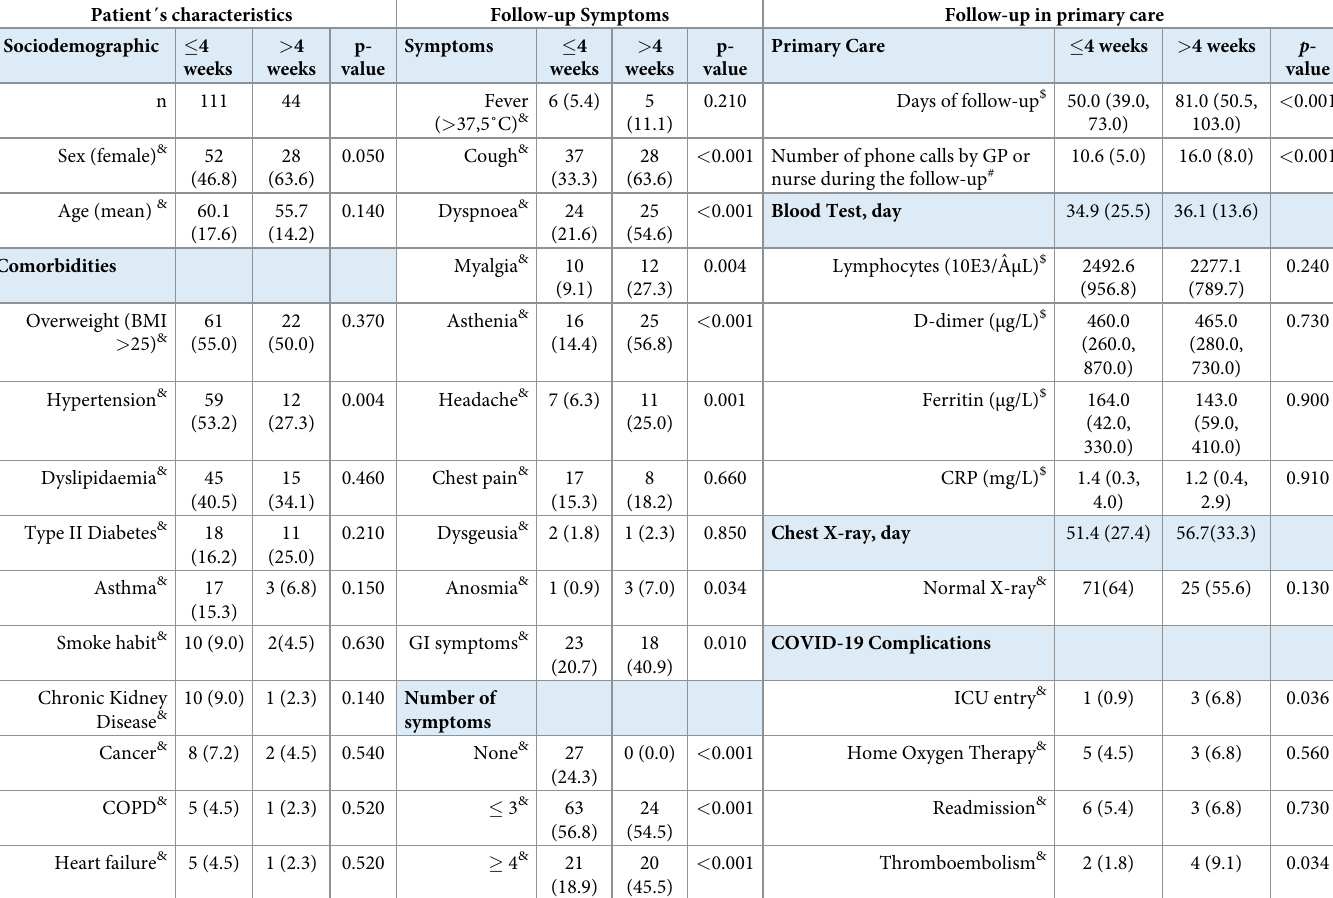
Table 3. Differences between patients with SARS-CoV-2 pneumonia clinical course of � 4 weeks and > 4 weeks (long COVID) from a 6 months follow-up in primary care